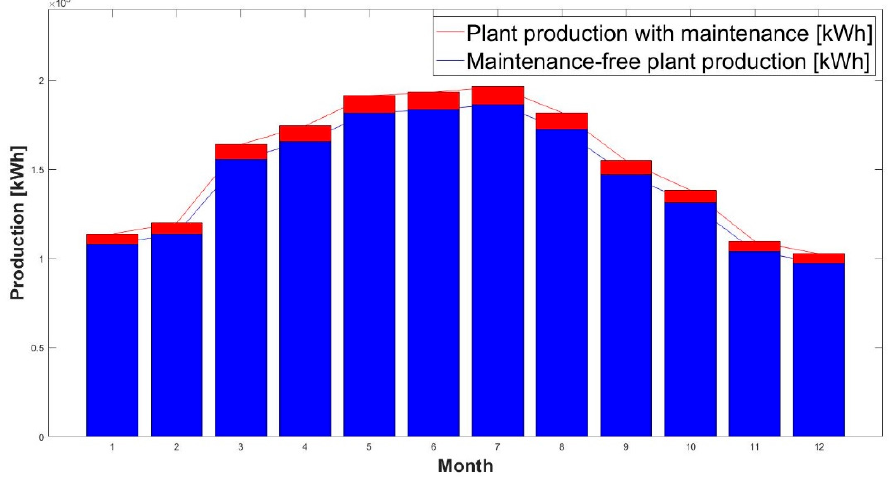
Figure 18. Variation in production at the 1 MWp plant.